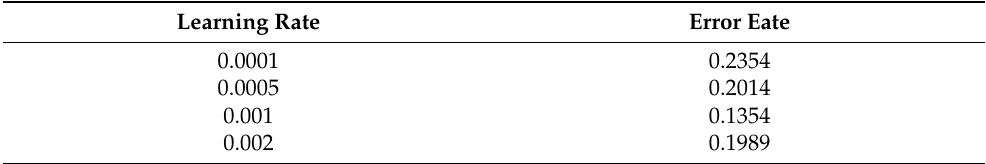
Table 2. Selection of optimum learning rate after experimentation.